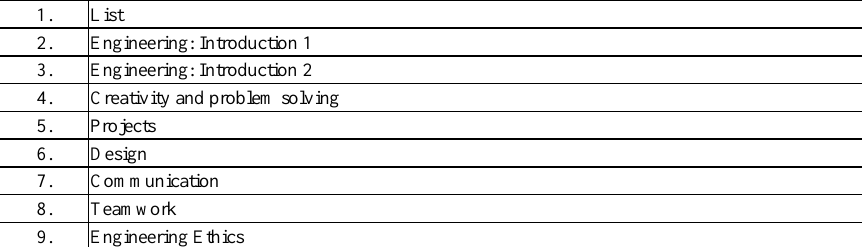
Table 4. A list of topics for the presentations on the general information of